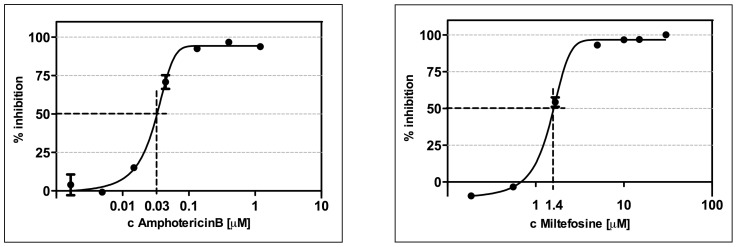
Dose response curves for amphotericin B and miltefosine against intracellular L. donovani amastigotes.Parasites were released by conditional lysis with saponin from bone marrow derived macrophages of BALB/c mice after 72 h incubation with anti-leishmanial standard drugs. Using this method, the measured activities of amphotericin B (EC50 29 nM) and miltefosine EC50 (1.45 µM) were reproducible and comparable to reported values against intracellular L. donovani (43–45). Representative plots for amphotericin B (n = 4) and miltefosine (n = 3) are shown. (R2
AmphoB – 0.9905, R2
Mil – 0.9963).